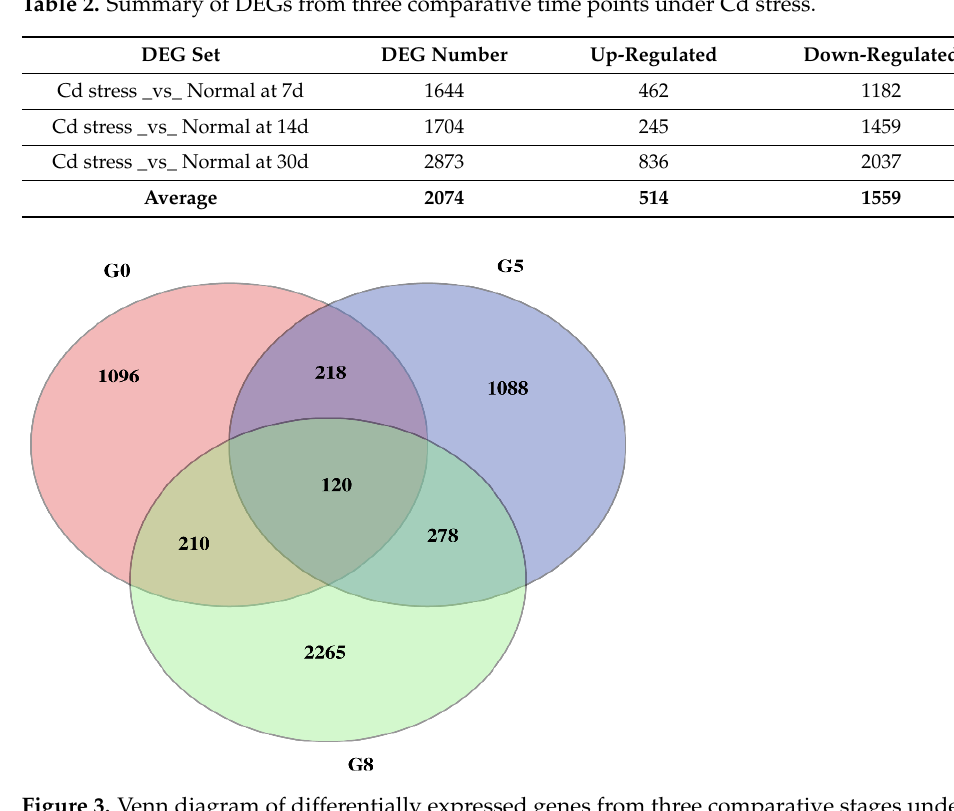
Figure 2. Correlation among RNA-Seq libraries at different time points of Cd stress. The X- and Y- axes represent each sample in a different time period. The expression values are log2-transformed median-centered FPKM. Cyan and purple color intensity indicates contig up-regulation and down- regulation, respectively. Table 2. Summary of DEGs from three comparative time points under Cd stress.